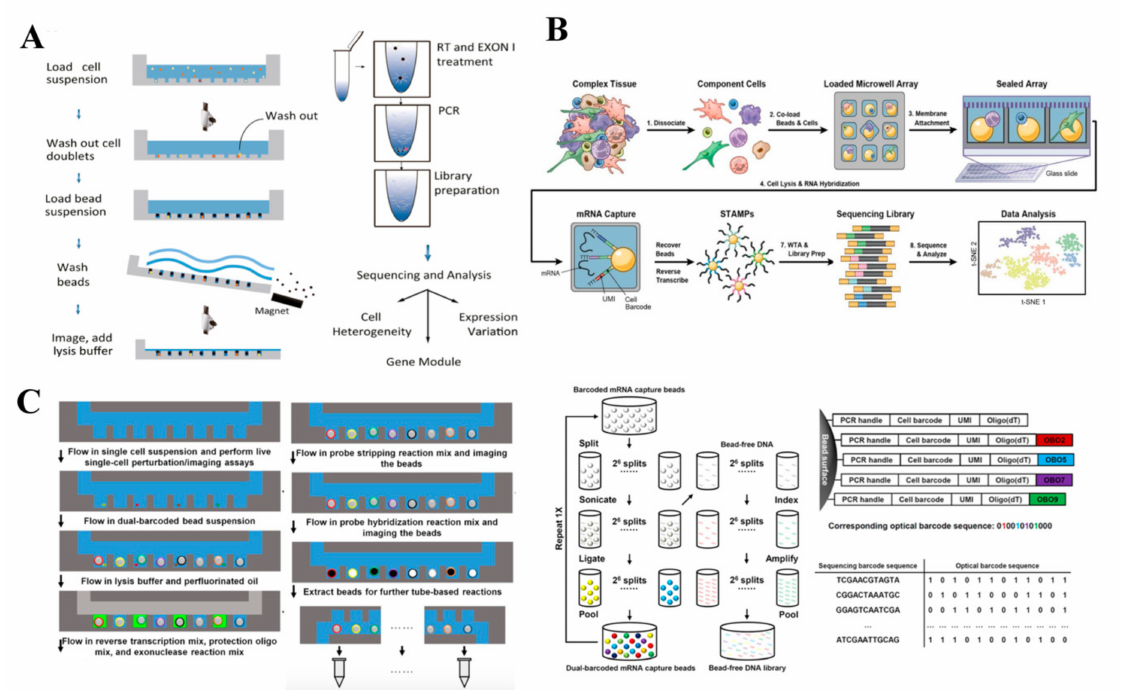
Figure 5. Nanowell-based scRNA-seq technologies. ( A ) Microwell-seq utilizes agarose-constructed Nanowells to profile thousands of single cells. Adapted with permission from Reference [26] © Elsevier, Netherlands(2018). ( B ) Seq-well leverages an advantage of arrays of Nanowells with the use of a semipermeable membrane to reduce cross contamination between wells in order to achieve massively parallel scRNA-seq. Adapted with permission from Reference [25] © Springer Nature (2017). ( C ) (i) Workflow of SCOPE-seq, a technology which is able to identify each individual cell based on their phenotypic profile and link phenotypic information to scRNA-seq data using dual-barcoded mRNA capture beads. (ii) Synthesis process of dual-barcoded mRNA capture beads. Adapted